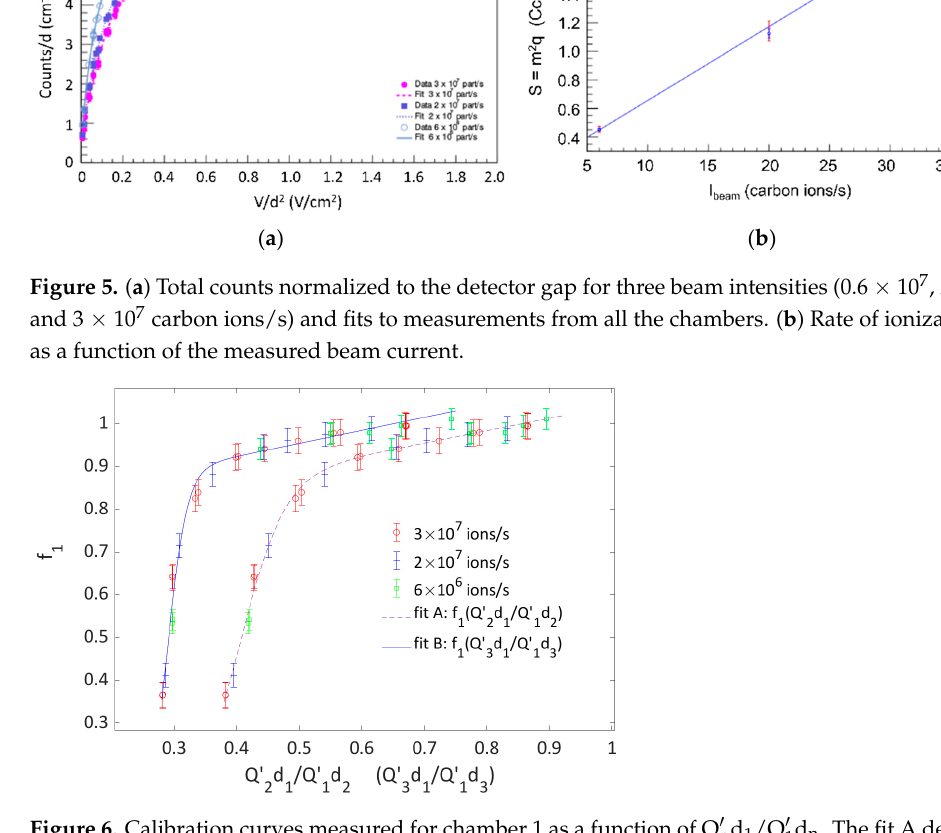
d n . The fit A describes 1